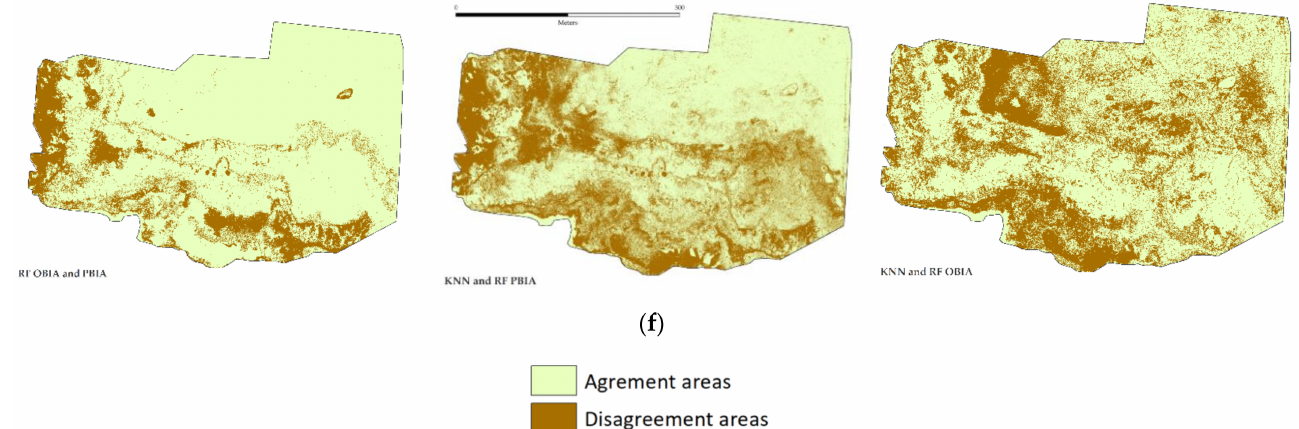
Figure A2. Distribution and extent of agreement and disagreement areas per study area. ( a ) Kudani, ( b ) Ralby, ( c ) Rumpo East, ( d ) Tahu South, ( e ) Tahu North and ( f ) Matsalu02. From left to right: changes in RF in OBIA and PBIA classification; changes in KNN and RF in PBIA classification; and changes in KNN and RF in OBIA